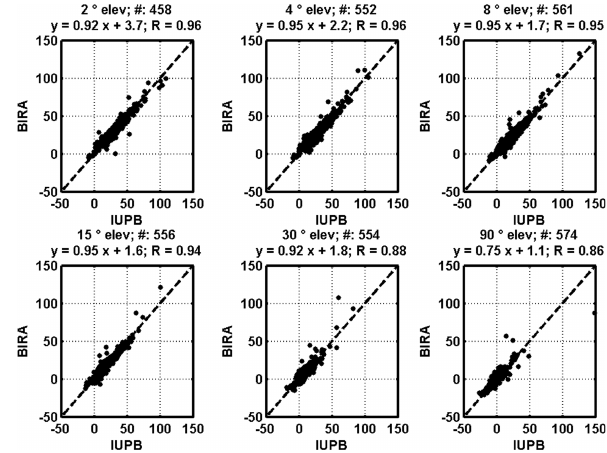
Fig. 3. HCHO vertical columns (moleccm − 2 ) retrieved from BIRA-IASB MAX-DOAS measurements at 30 ◦ elevation using a geometrical approximation. (a) Time series of observations per- formed during June and July 2009. Ambient temperature measure- ments are superimposed in blue. (b) Corresponding mean diurnal variation of the HCHO vertical column. Error bars denote the one sigma standard deviations around the mean values.